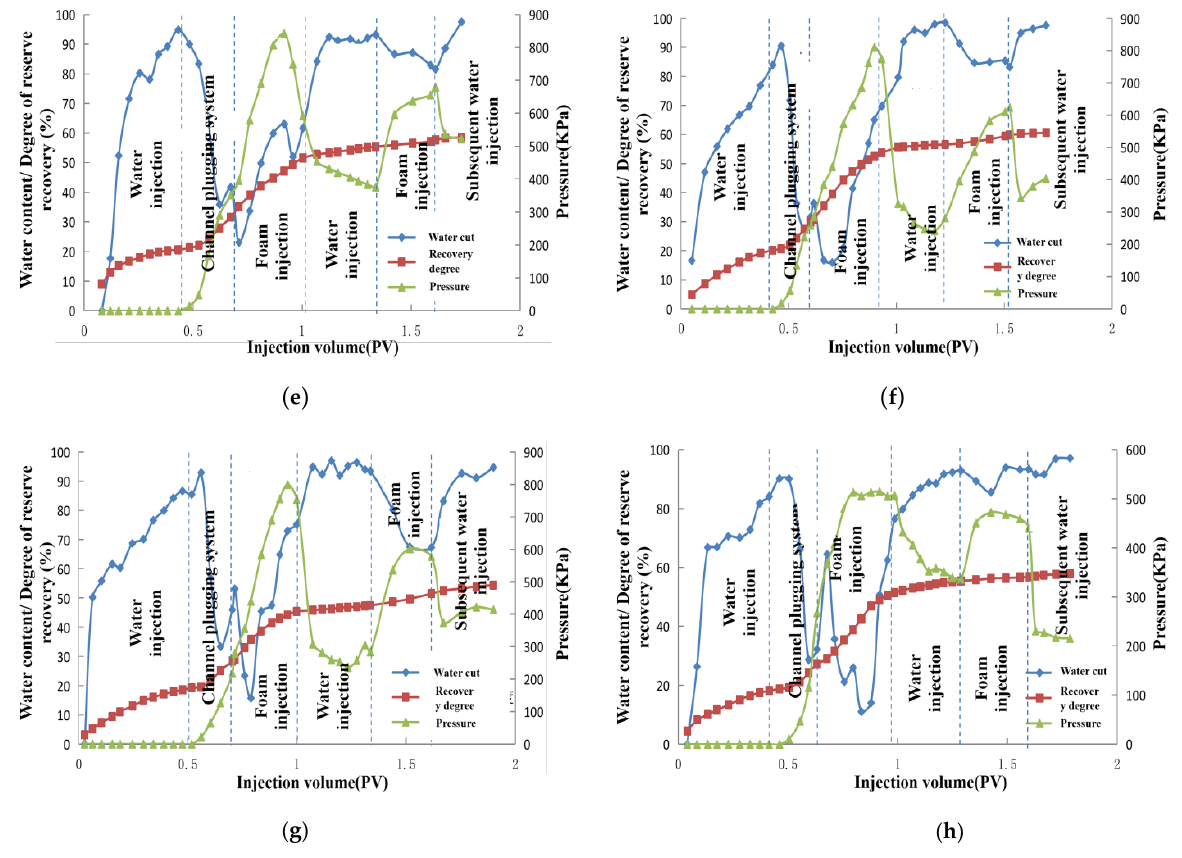
Figure 6. Dynamic characteristics of oil displacement in the inter-layer heterogeneous model. (Note: These four schem ( e – h ), all show the relationship between water content/Pressure/Degree of reserve and injection volume at different stages.)